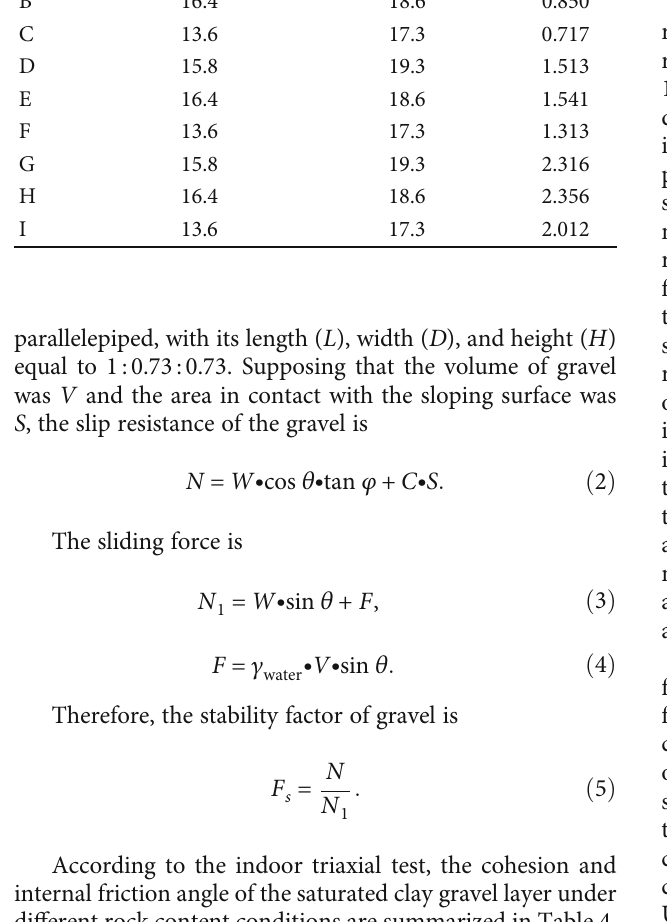
Table 4: Stability coe ffi cient of gravel fall of clay gravel layer slope. Test Saturated cohesion number of gravel layer (kPa)